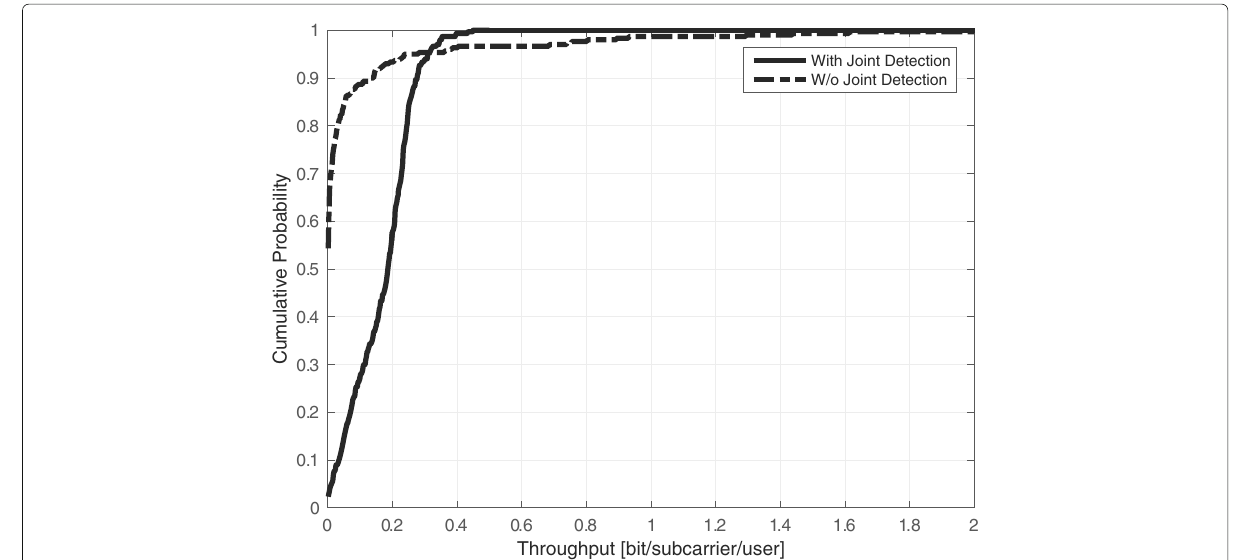
Fig. 6 System throughput performance in pico cell (10